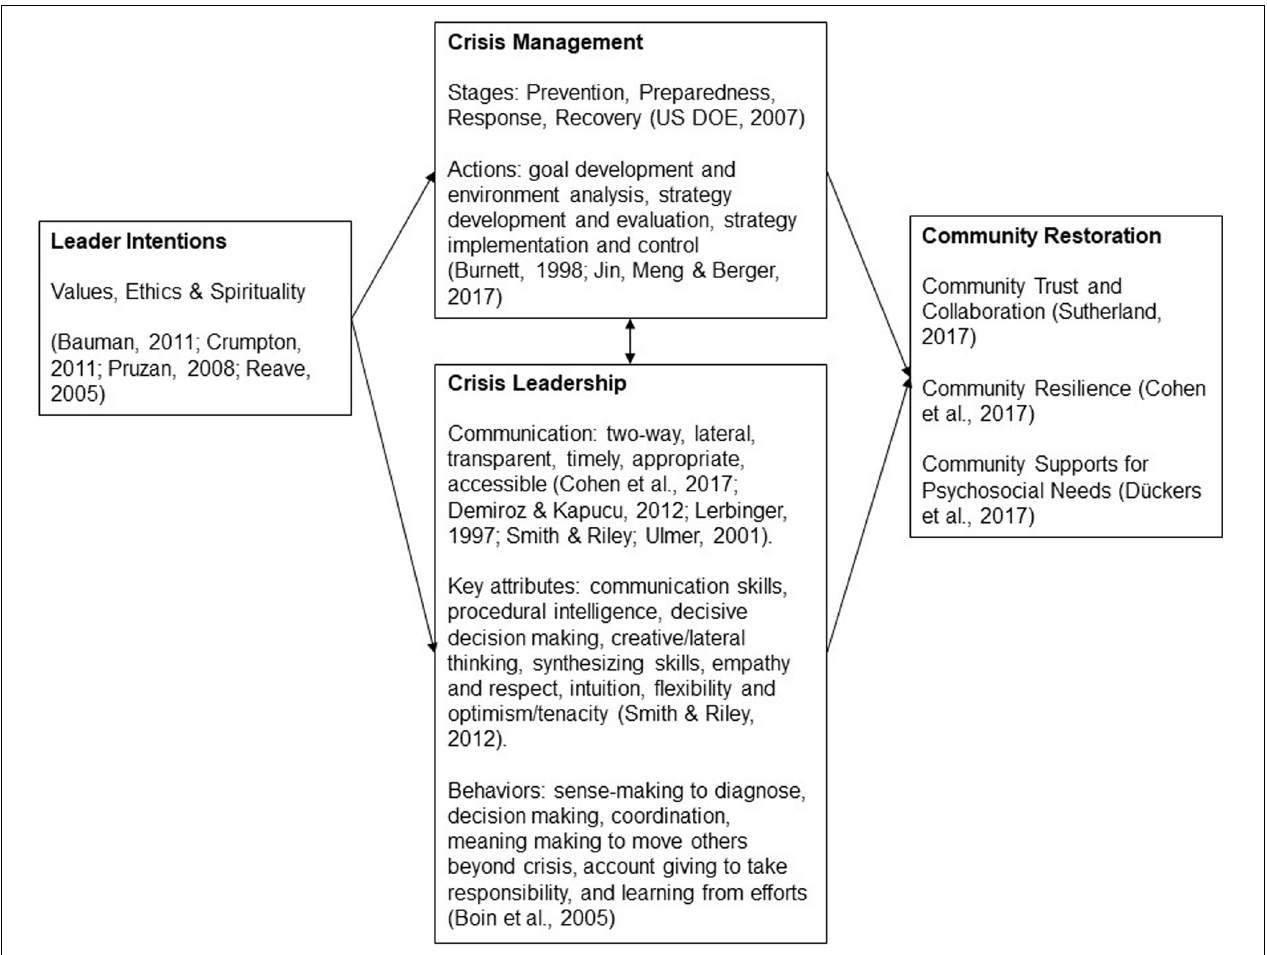
FIGURE 1 | Synthesis of intentions, characteristics and purpose of crisis management/leadership across disciplines as a framework for school